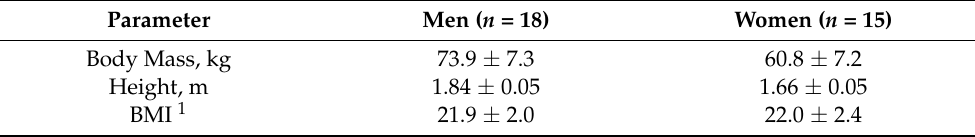
Table 4. Anthropometric characteristics of the participants at the time of their inclusion in the study.